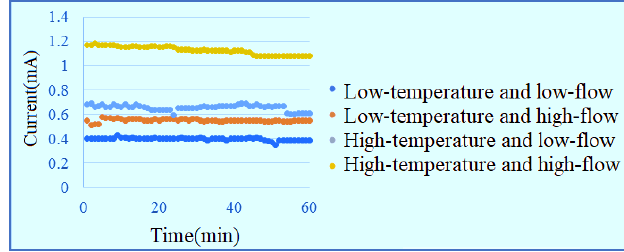
Figure 13. Current data at upper outlet of runner.